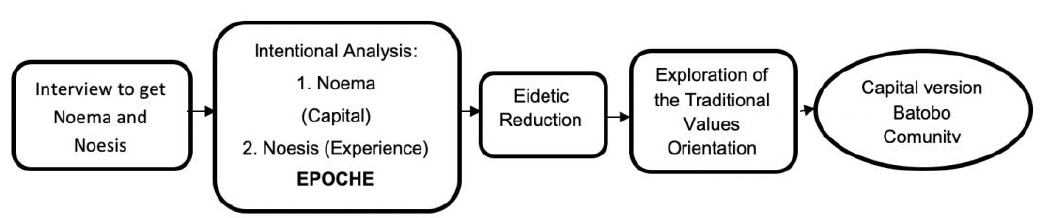
Figure 1: Data Analysis; Source: Fenomenology Transcedental